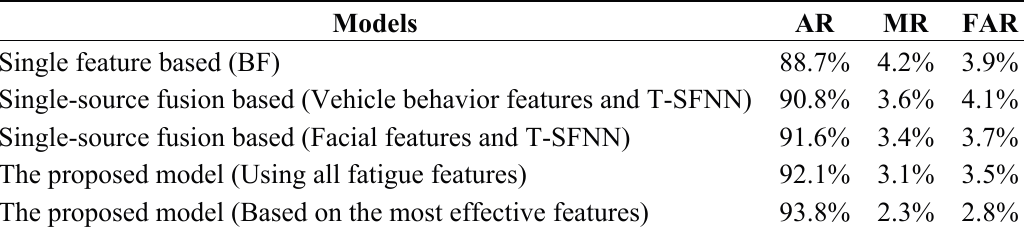
Table 9. Performance comparisons of five